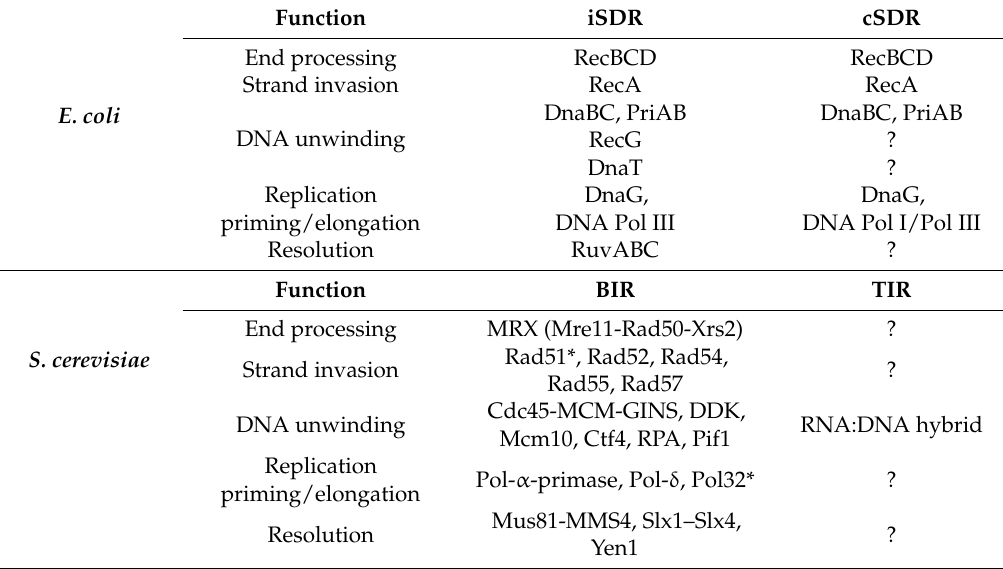
Table 2. Factors required for origin-independent DNA replication by iSDR/BIR or